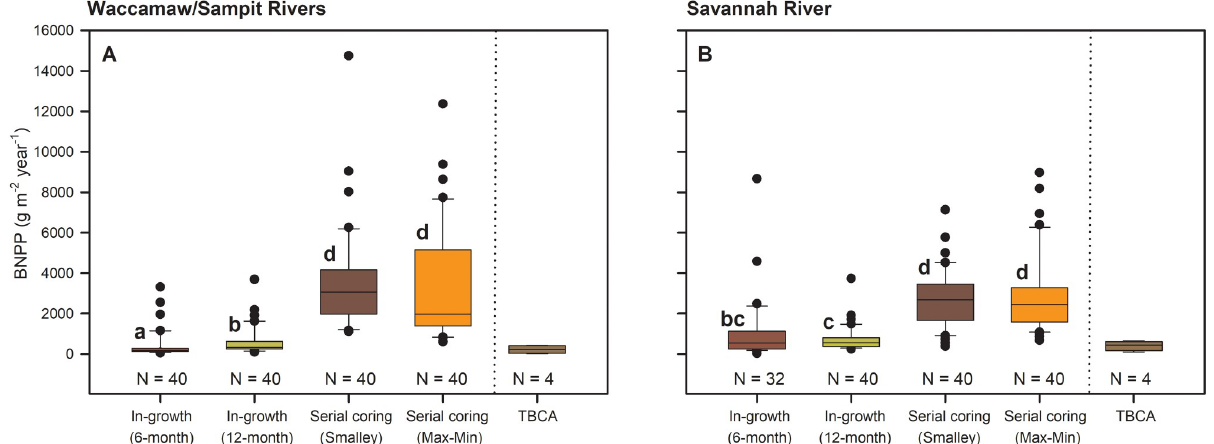
Fig 2. Belowground net primary productivity (BNPP, median) by river. (A) Waccamaw/Sampit Rivers, South Carolina; and (B) Savannah River, Georgia, as estimated using root ingrowth techniques over 6 months, root ingrowth techniques over 12 months, Smalley estimation of serial coring data, Max-Min estimation of serial coring data, and total belowground carbon allocation (TBCA) for data collected from TFFW transitioning to marsh. Mean values by technique and river followed by the same letter do not differ significantly (Technique × River × Site, n.s.; Technique × River, F 3,280 = 9.77, P <